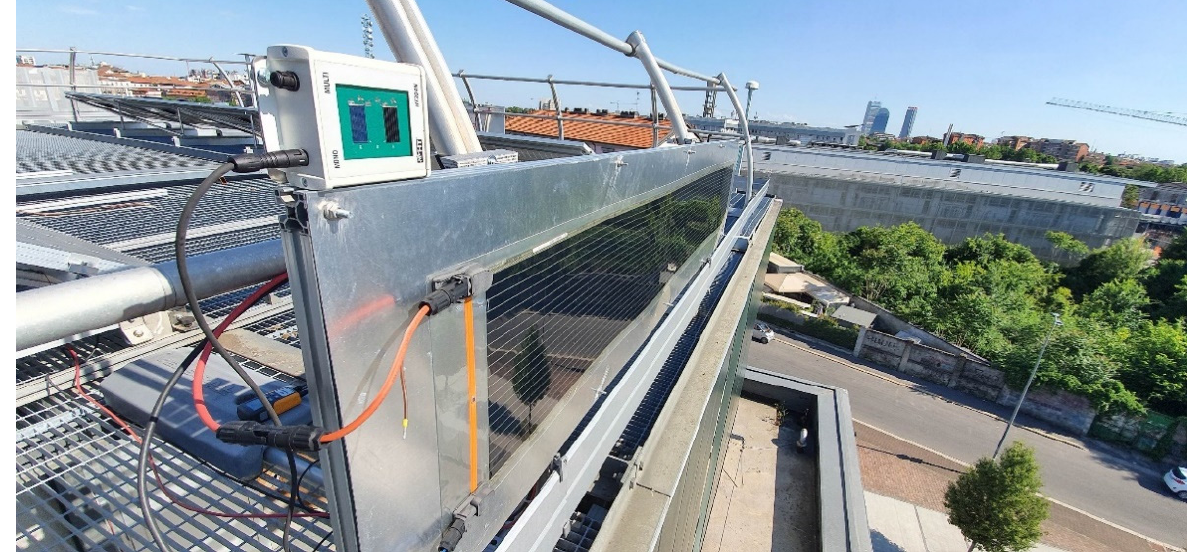
Figure 4. OPV module facing west (OPV ‐ W) installed at the edge of the test facility.